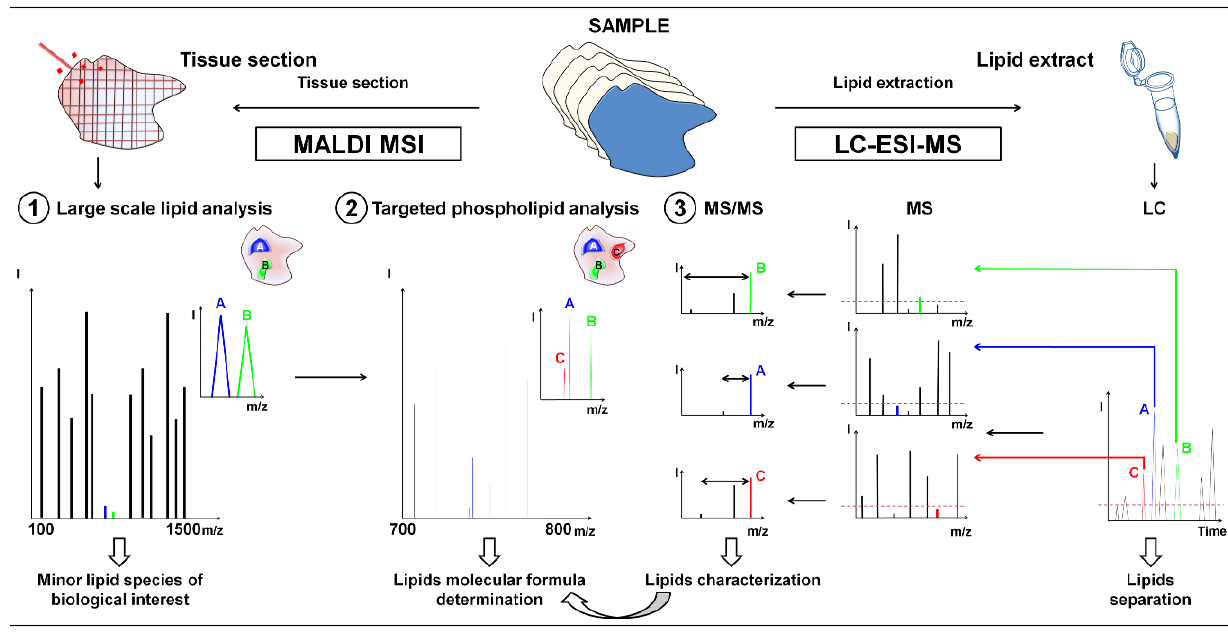
Figure 1. General workflow for the characterization by LC-ESI-MS guided by MALDI MSI of low-abundant lipids in tissue using FTICR mass spectrometry. ( 1 ) Large scale lipid analysis by MALDI MSI to target lipids of biological relevance after comparison with histochemical staining; ( 2 ) Targeted MALDI MSI analysis and molecular formula determination by exact mass measurement; and ( 3 ) LC-ESI-MS analyses for the characterization of low-abundant PL classes from lipid